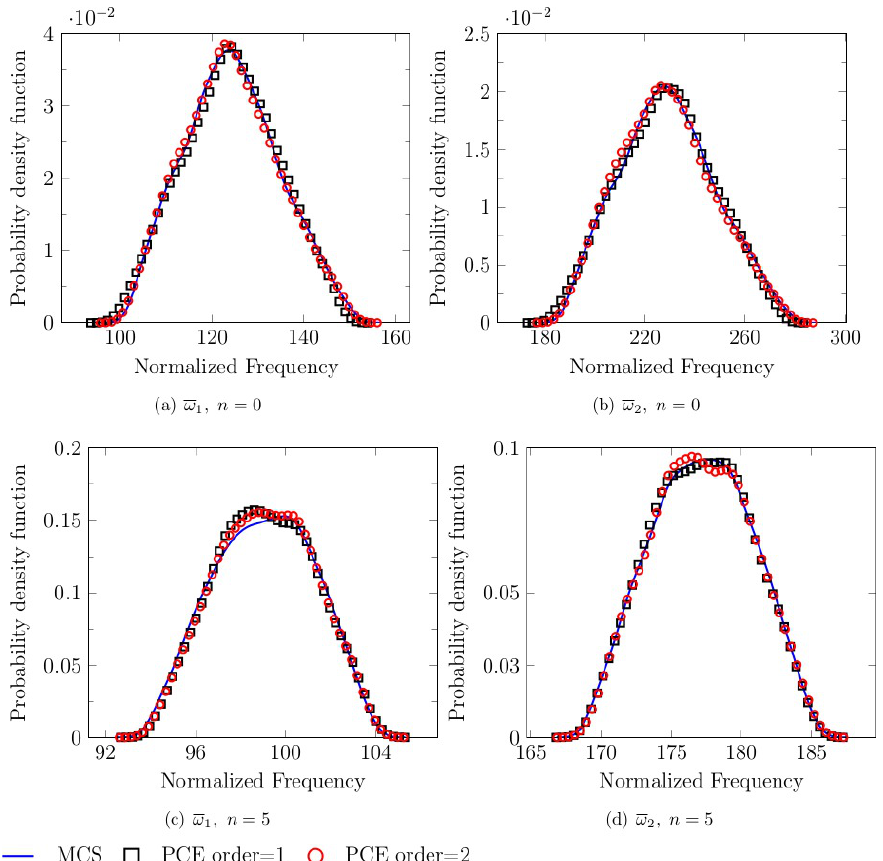
Figure 6. Case B: Variation of the probability density function as a function of normalized frequency, for the first two normalised frequencies; considering gradient index, n = 0, 5 and the Young’s modulus and density of the ceramic as random.